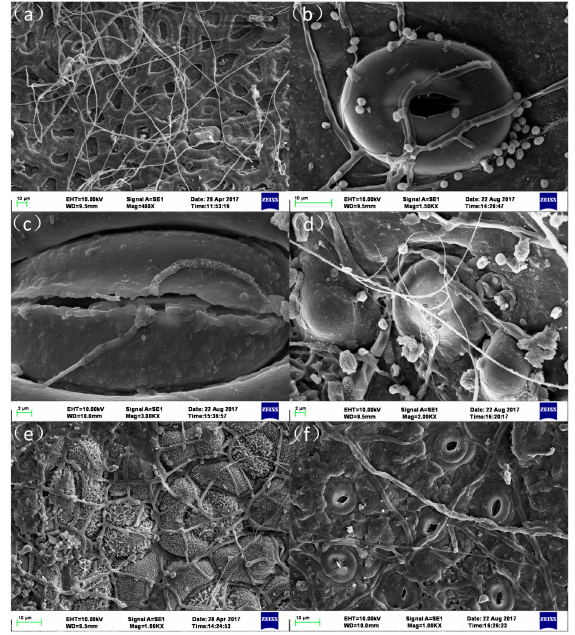
Figure 6. Scanning electron micrographs of abaxial leaf surface of epiphytes and their host trees. Fungal hyphae covering the stoma of B. ambrosia ( a ) and B. delitescens ( b ); an unidentified fungal endophyte penetrating a single stoma of C. viscosa ( c ) and H. pottsii ( d ); capping of the stomatal pore